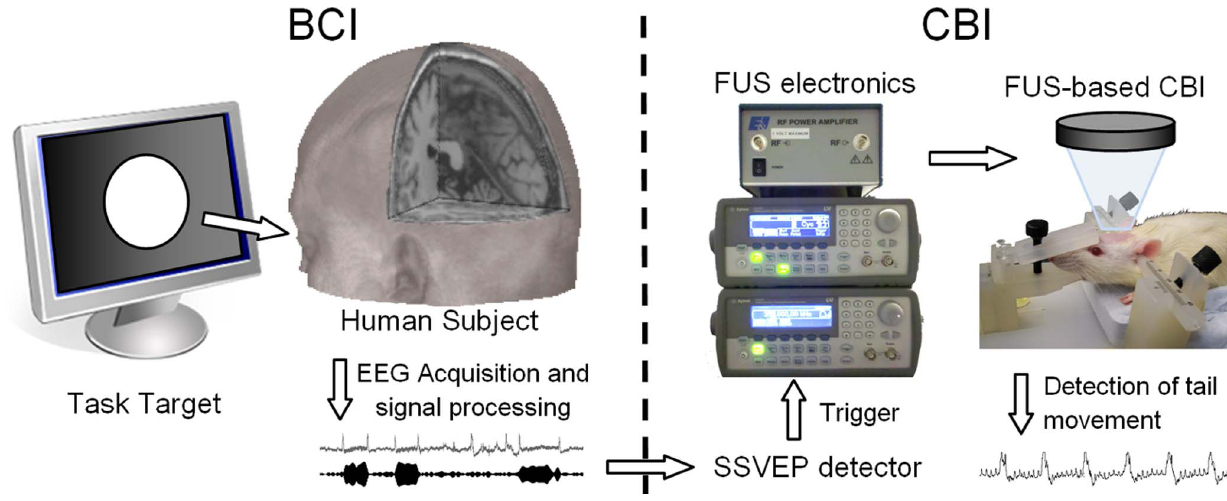
Figure 1. The schematics of the implemented brain-to-brain interface (BBI). The implementation consists of steady-state visual evoked potential (SSVEP)-based brain-to-computer interface (BCI: on the left column) and focused ultrasound (FUS)-based computer-to-brain interface (CBI) segments (on the right column).